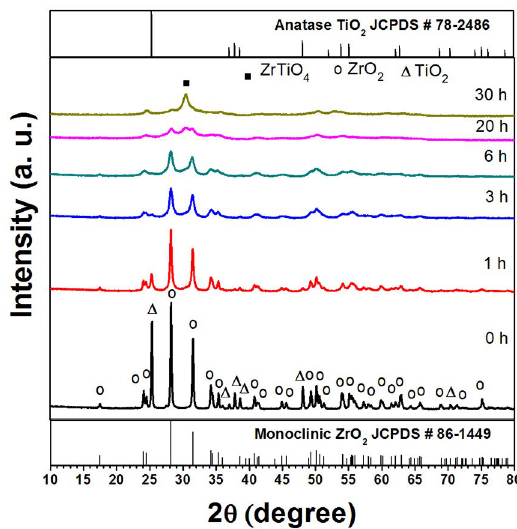
Figure 1. XRD patterns of samples after different milling times.